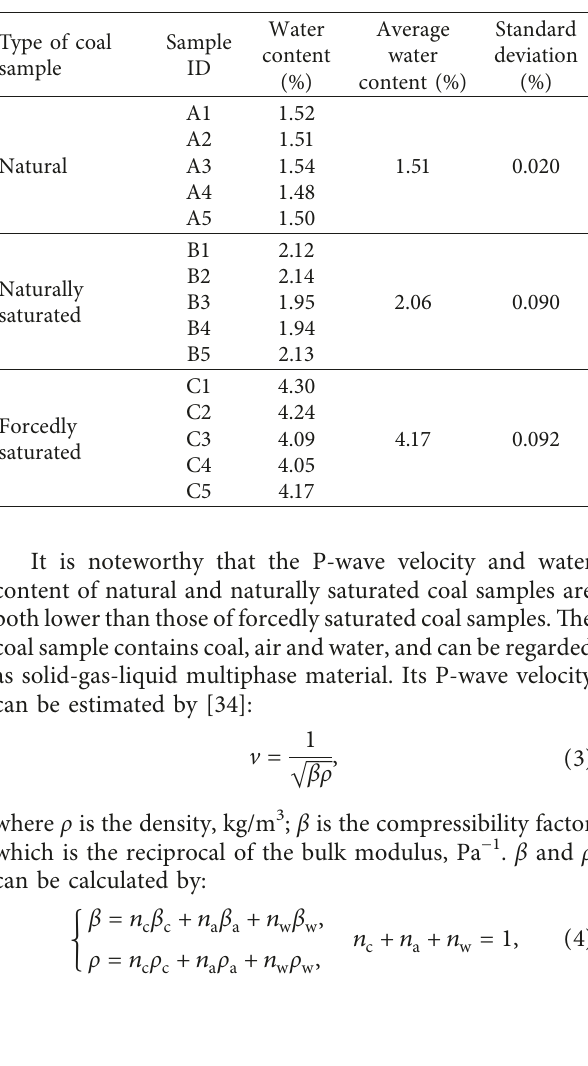
Figure 5: Mechanical experiment system used to conduct UCS tests and AE measurements. Table 2: Water content of three kinds of coal